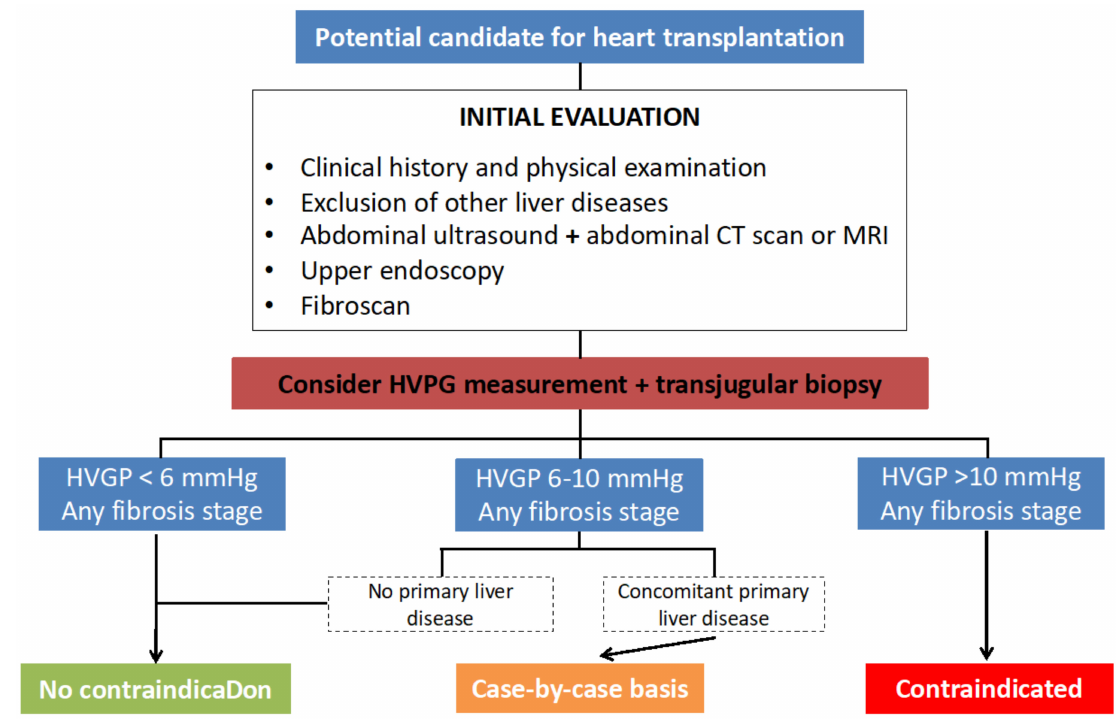
Figure 10. Protocol to determine the recommendation regarding liver disease in a potential candidate for a heart transplant when CH is suspected. We proceed to HVPG measurement and transjugular biopsy in those patients in whom advanced liver disease cannot be ruled out after the initial evaluation (e.g., nodular appearance of the liver). Our recommendation is hemodynamic-dependent, regardless of the fibrosis stage. In cases with a HVPG below 5 mmHg, there is no contraindication to perform an isolated heart transplant, whereas a HVPG > 10 mmHg discards it (no combined heart-liver transplantation has been performed so far in our hospital). In patients with a concomitant primary liver disease and a HVPG between 6–10 mmHg, the decision is patient-specific and relies mainly on the type of disease. If it is treatable (e.g., hepatitis C or B), we recommend proceeding with the heart transplant. The same recommendation is given in the absence of a primary liver disease and a HVPG between 6–10